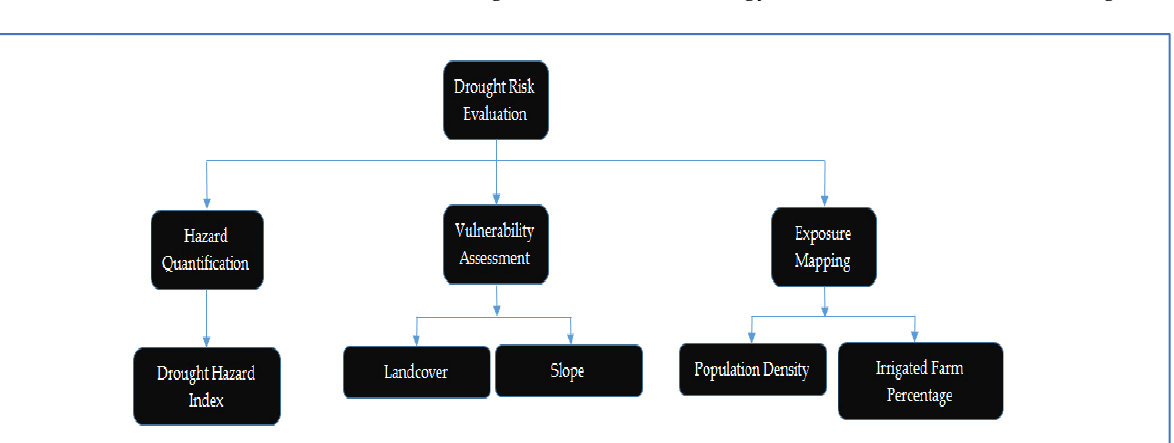
Figure 5. Block diagram of the research steps.